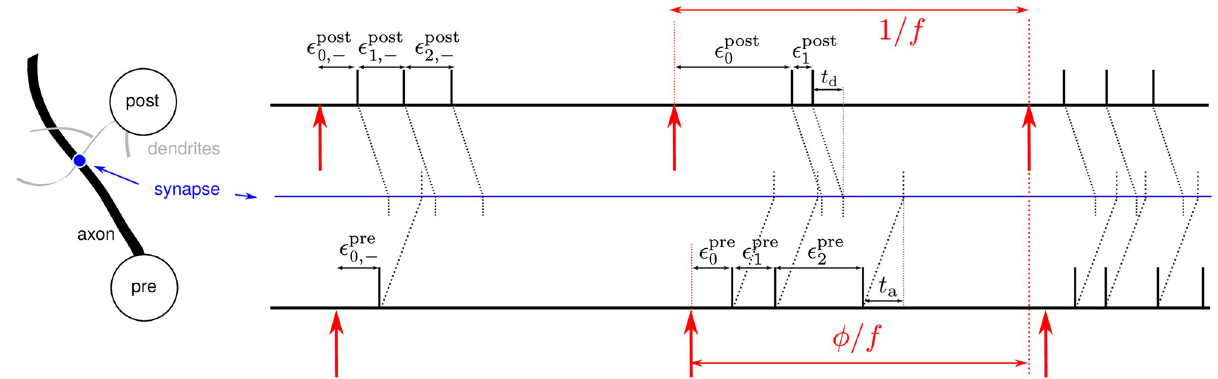
Fig 14. Schematics of the derivation of the estimated mean rate of weight change. During PMCS, the postsynaptic neuron and the presynaptic neuron (left) received stimuli at frequency f . Stimulus deliveries (red arrows) were phase shifted by a phase lag ϕ 2 [0, 1]. Each stimulus could trigger several spikes (vertical bars). Presynaptic spikes traveled along the axon and arrived with a time delay t a at the synapse (blue). Backpropagating postsynaptic spikes traveled along the dendrites and arrived with a delay time t d at the synapse. Interspike intervals � are marked by horizontal arrows. Indices count interspike intervals during respective PMCS cycles. Dashes refer to interspike intervals from the previous PMCS cycle. Suffixes ‘post’ and ‘pre’ indicate interspike intervals of the postsynaptic or presynaptic neurons,